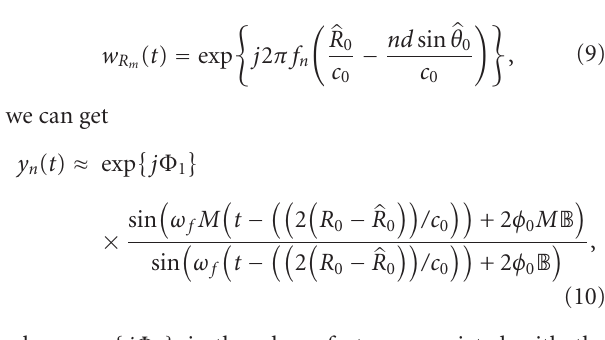
where B denotes (sin θ 0 − sin (cid:8) θ 0